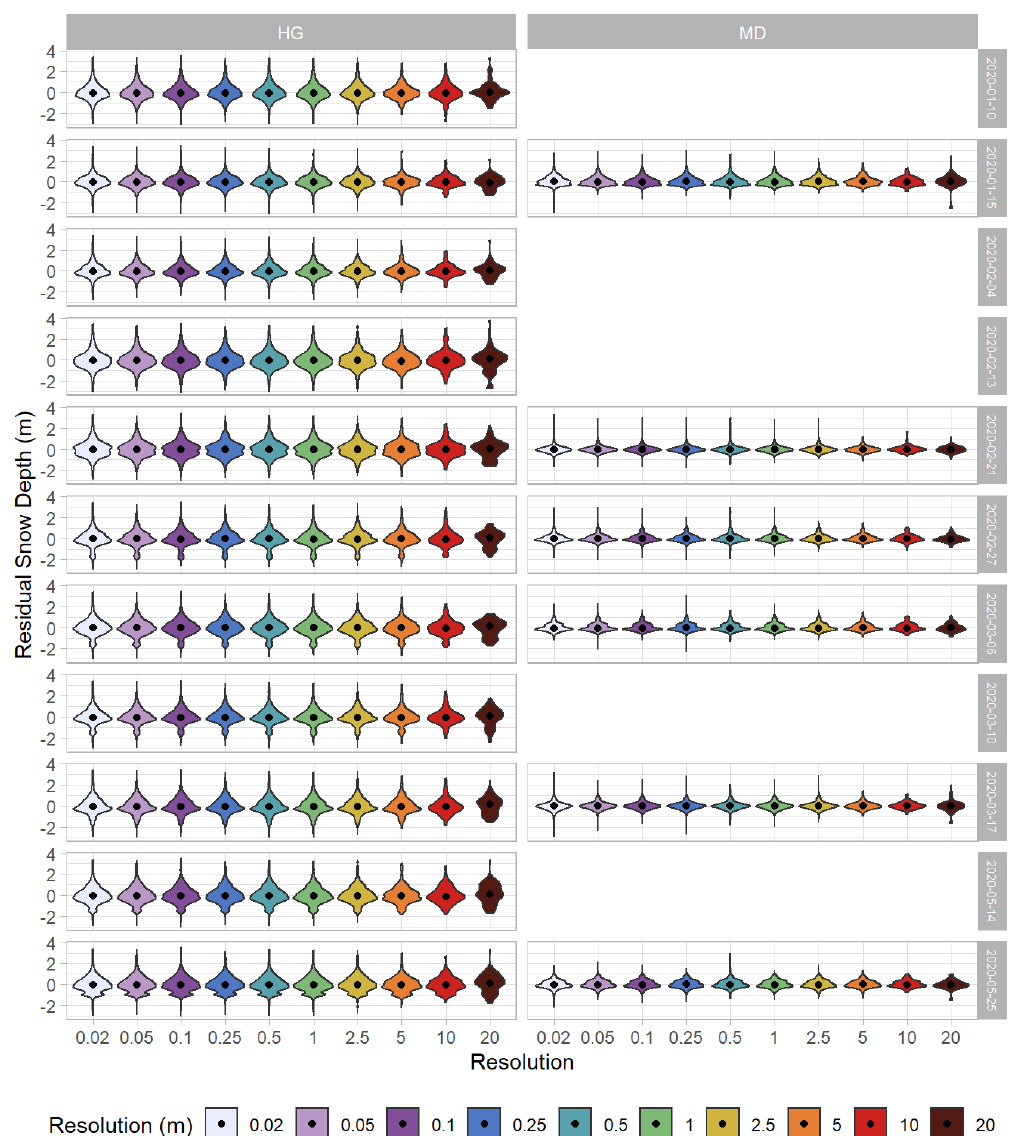
Figure A9. Violin plots of detrended snow depth residuals in the Hourglass (HG) and meadow (MD) sites with colors representing different resolutions. Black dots represent median values and color shades represent the distribution of points for each resolution on each sampling